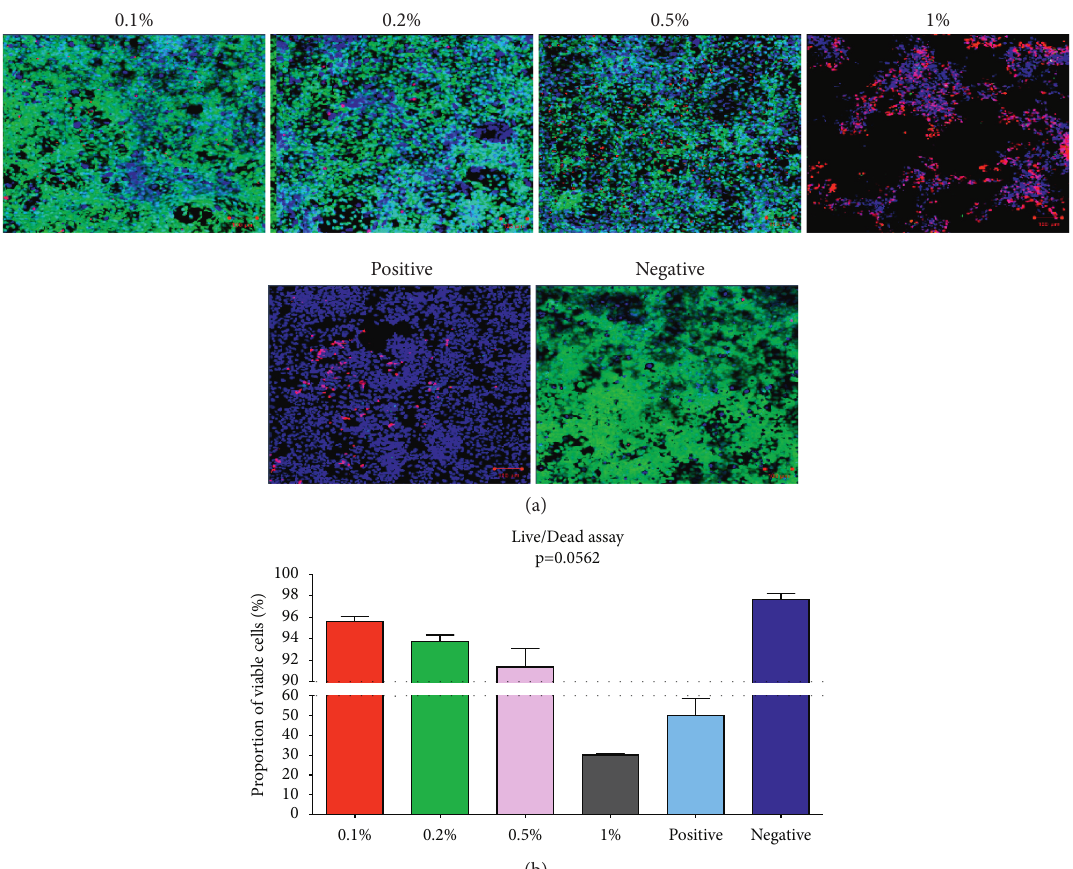
Figure 1: (a) Merged images of live/dead cell staining following cell culture in different concentrations of CoQ10 (Hoechst blue (nuclear), Ethidium homodimer-1 red (dead), and Calcein AM green (viable). (b) Graph showing the results of the mean (and SEM) proportions of viable